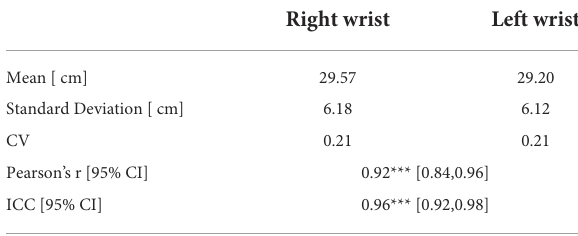
TABLE 2 Descriptive statistics and correlations of the left-right comparison between the CMJ-height measured by one Polar Vantage V2 sports watch attached to the right wrist and another one simultaneously attached to the left wrist.